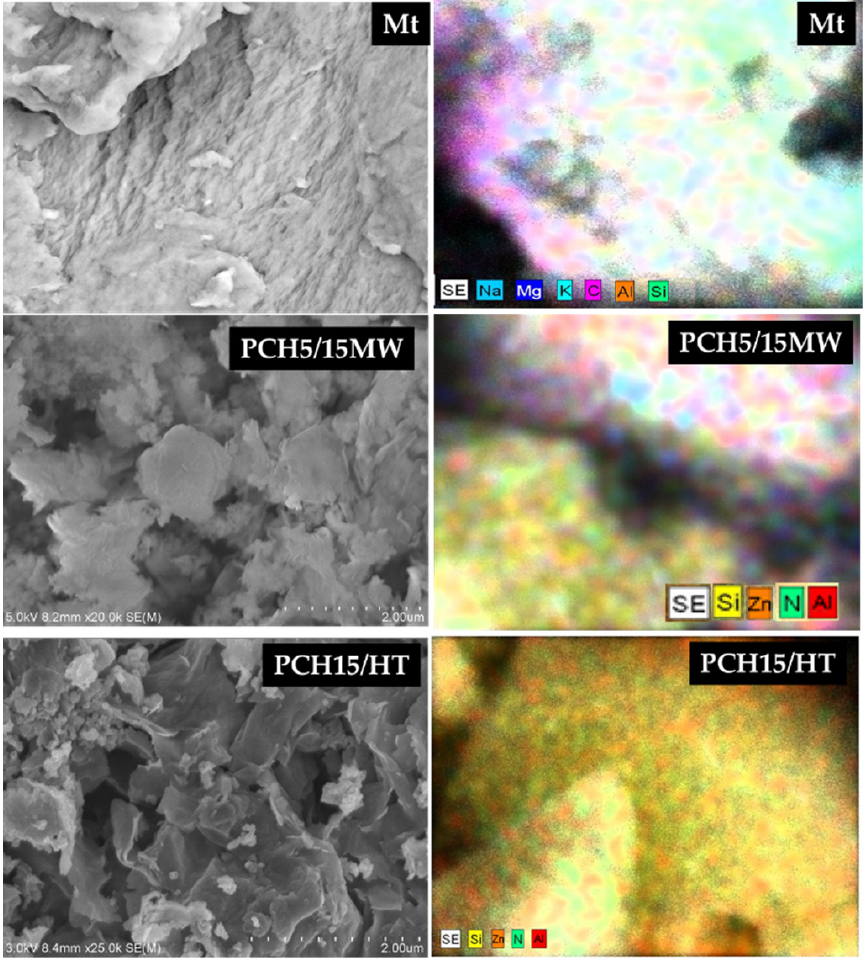
2 /SiO 2 -PCH samples.